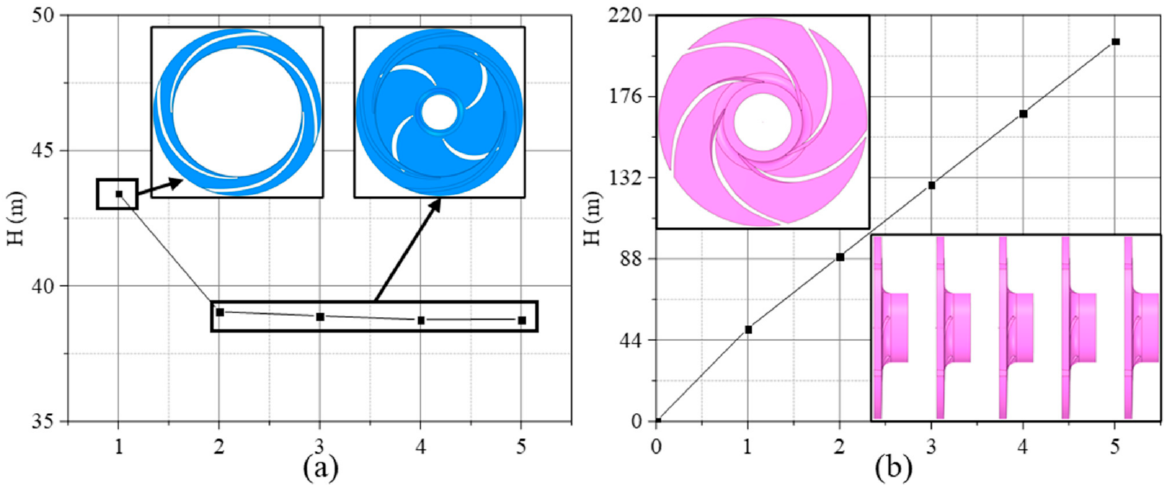
Figure 6. Head curves of multi‑stage PAT with different stages, ( a ) Head of different single‑stage impellers, ( b ) Head of impellers in different stages.